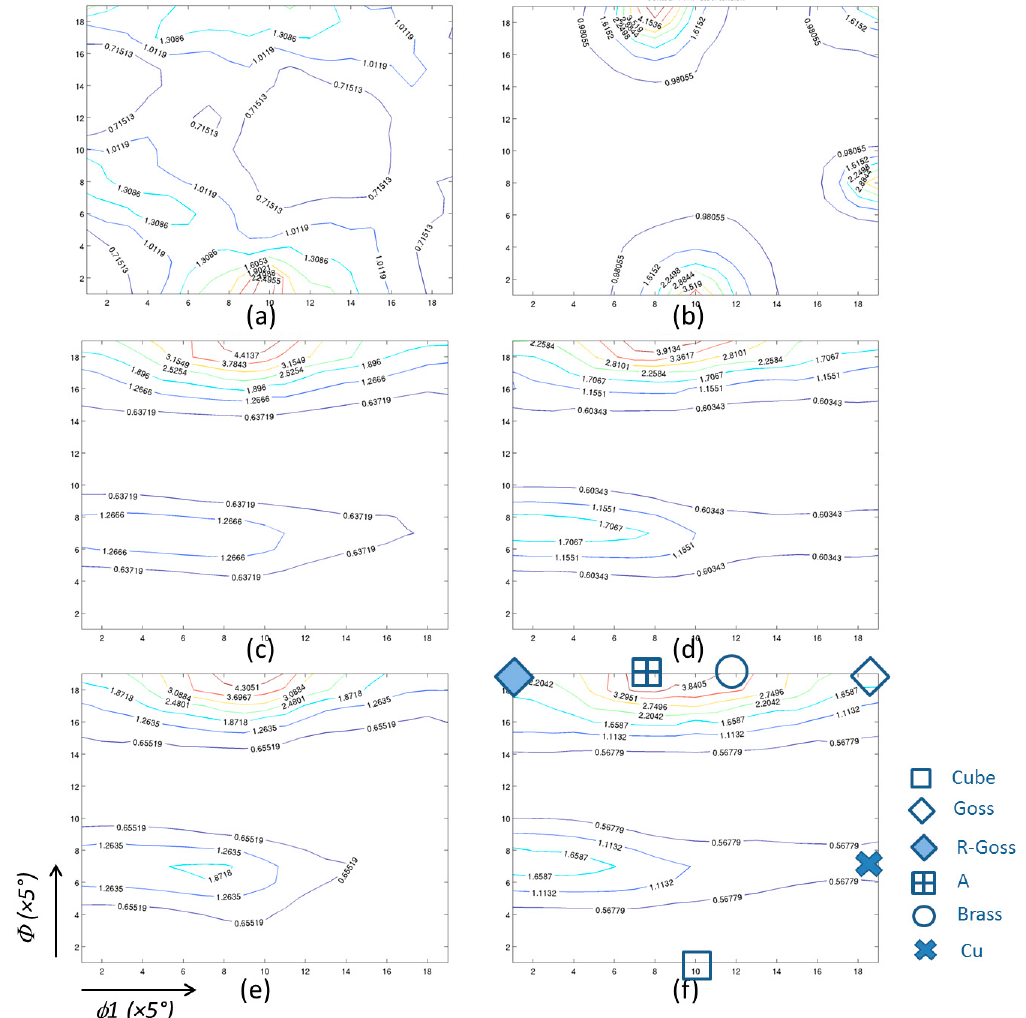
Figure 6. Orientation distribution function (ODF) section at φ 2 = 45° for the compression tested TWIP steel ( a , c – f ) and a specimen that experienced uniaxial tensile deformation to 20% elongation ( b ). (a) As-received specimen; (b) tensile deformed to 20% strain; (c) specimen compression tested to a